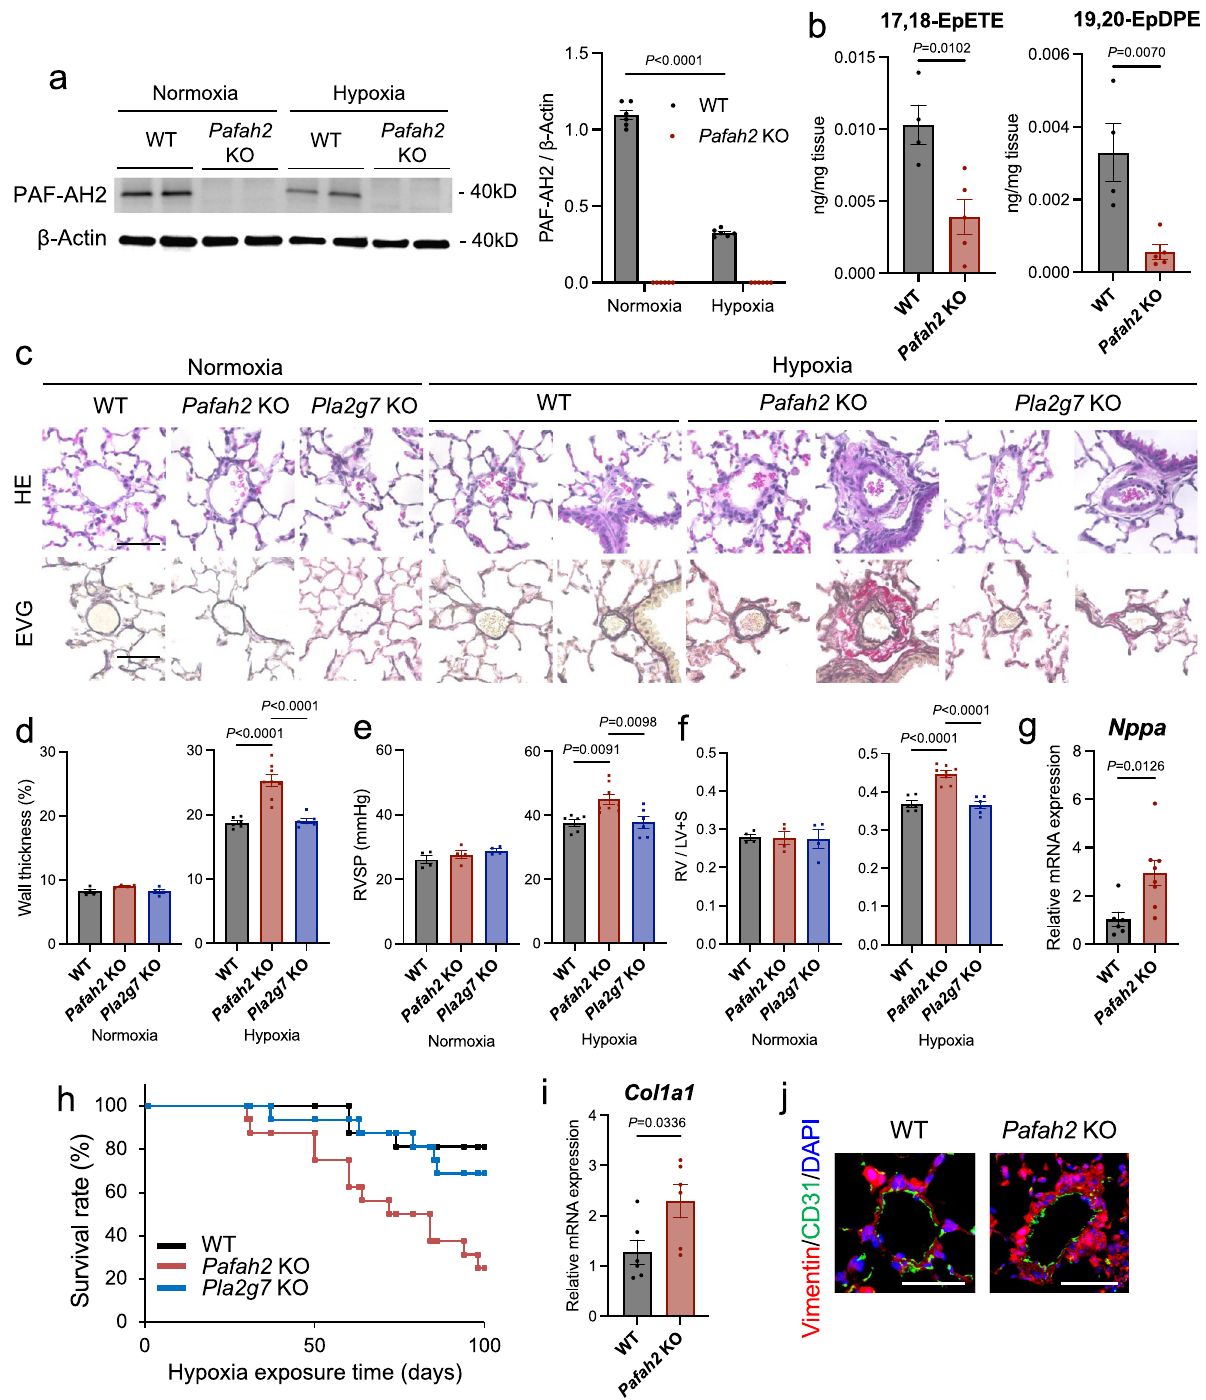
the Pafah2 KO BMMCs increased the proliferation of fi broblasts and mRNA expressions of fi broblast activation markers, includ- ing Col1a1 and Acta2 , compared to the supernatants of the WT BMMCs. Additive treatment with ω -3 epoxides suppressed the aberrant proliferation and upregulation of the activation marker genes in the fi broblasts stimulated with lipid extracts from the Pafah2 KO BMMCs (Fig. 4a, Supplementary Fig. 6a). The pro- liferation of lung fi broblasts was suppressed by treatment with ω - 3 epoxides, 17,18-EpETE or 19,20-EpDPE, but not by EPA, DHA, or their dihydrodiols (Fig. 4b, Supplementary Fig. 6b).